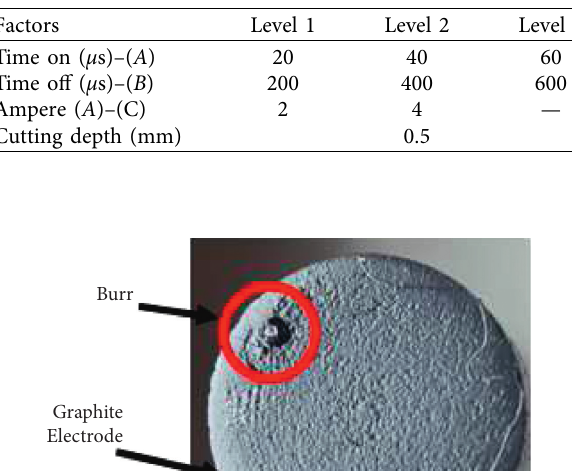
Table 2: Taguchi L 18 test parameters and levels used in the ex- perimental study.